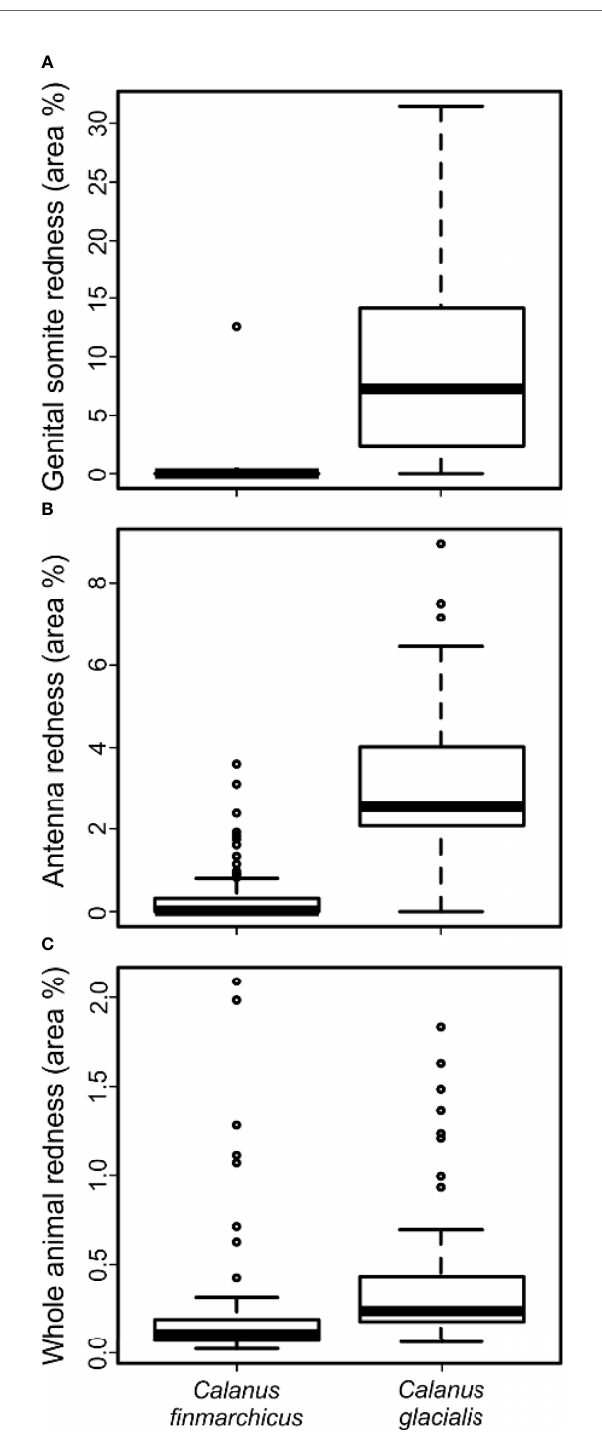
FIGURE 3 | Percentage of red pixels (area %) within selected regions of Calanus fi nmarchicus and Calanus glacialis : Redness of the genital somite (A) , antennae (B) and whole animal (C) . Boxplots illustrate the median (thick horizonal lines), interquartile ranges (top and bottom of boxes = third and fi rst quartile, respectively) and 1.5 times the interquartile ranges